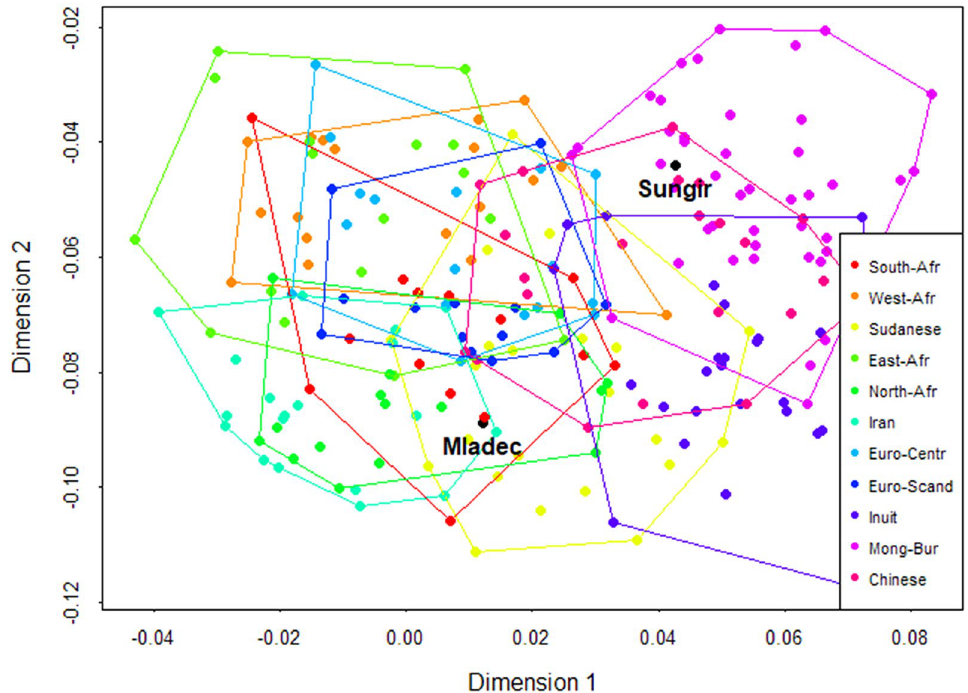
Figure 3. Individual shape configurations projected into the space of the first two shape dimensions of the RRR. Dimension 1 accounts for 73% and Dimension 2 for 21% of the shape variation related to